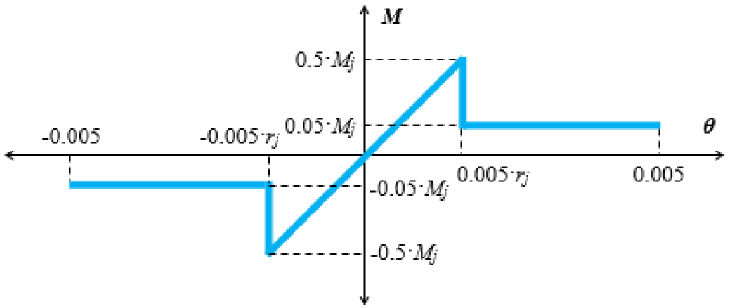
Figure 5. Moment–Rotation ( M – θ ) relationship representing the shear response of R/C beam-column joints in an intermediate floor of a building (the 0.5 factor for the moment is replaced by 1.0 for a roof joint in the